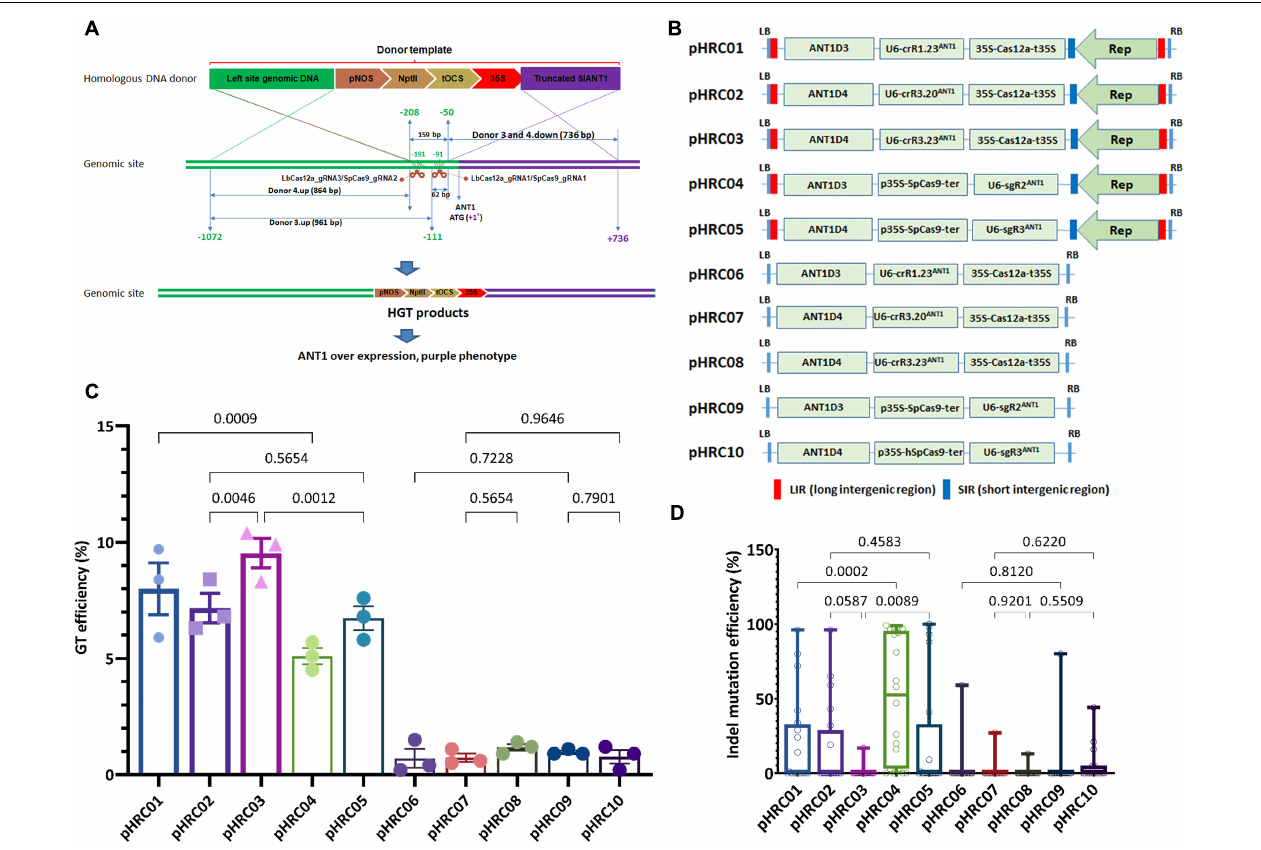
FIGURE 2 | Performance of the LbCas12a and SpCas9 nucleases in GT-mediated DNA insertion in tomato. (A) Schematic diagram of CRISPR/Cas-based GT processes. The SlANT1 genomic site was cleaved by the CRISPR/Cas complexes at the positions of LbCas12a_gRNA1 and 3 and SpCas9_gRNA1 and 2, denoted by scissors. Subsequent repairs of the DSBs were conducted with the addition of donor templates that contain upstream homologous arms (corresponding to Donor 3.up and Donor 4.up) and downstream truncated SlANT1 (corresponding to Donors 3 and 4.down) of the DSB sites and the inserted sequences containing the kanamycin selection marker (pNOS-NptII-tOCS) followed by a CaMV 35S promoter (35S) for constitutively driving SlANT1 expression. The lengths in bp of the homologous arms are also shown. The distances in bp among the cleaved sites and the starts and ends of the donor sequences were calculated and illustrated in relation to the ATG start codon of the SlANT1 gene with the A as the +1 position. The sequence upstream of the SlANT1 start codon is drawn by the green lines, and purple lines are drawn for the downstream part. The crossing discontinuous lines between the homologous DNA donor and genomic site depict the expected homologous recombination for sequence exchanges. Successful GT would integrate the selection marker and 35S promoter at the DSB sites, thereby supporting event selection and screening by kanamycin antibiotic and purple phenotype. (B) Binary vectors used for comparison of SpCas9- and LbCas12a-based GT performance. Each vector contained a homologous donor described in panel (A) and the Supplementary Data 1 , an expression cassette of sgRNA/crRNA and SpCas9 or LbCas12a expression cassette. Two sets of vectors were used: only T-DNA and replicon-based systems for comparison. (C) Scatter dot-bar plots showing the GT efficiencies of the tested constructs. (D) Boxplot showing the indel mutation efficiencies of the GT constructs at the plant stage. The GT efficiencies were calculated at 21 dpt. Multiple comparisons of the means and plotting were conducted by GraphPad Prism version 9 using one-way ANOVA and Fisher’s LSD test. The p -values of each compared mean pair are shown on the top of the